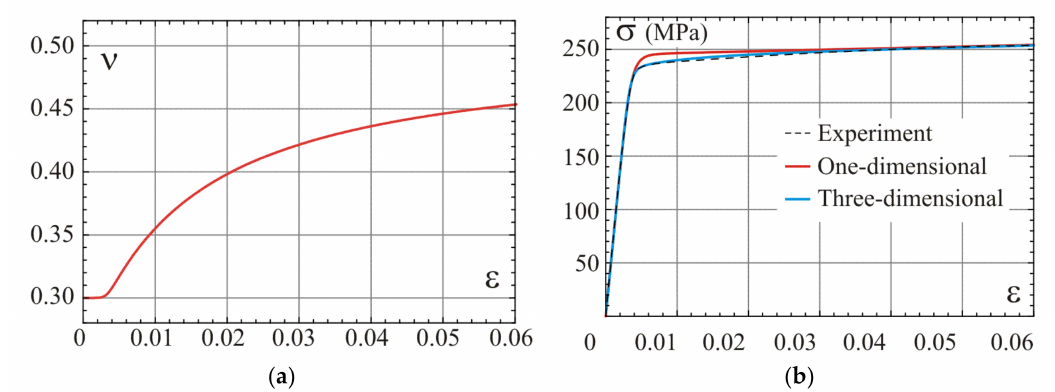
Figure 8. ( a ) Poisson’s ratio for the compressible model, ( b ) stress–strain relation for the one-dimensional model and the uniaxial tension of the three-dimensional model with